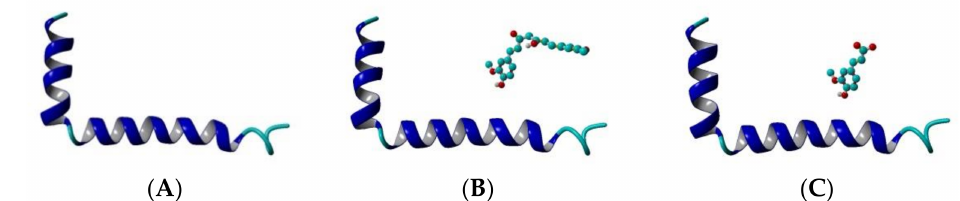
Figure 2. Initial topology of the systems modelled in the present study: ( A ) A β peptide, ( B ) A β peptide and CU, ( C ) A β peptide and FA. The peptide is given in cartoon, the ligand–in ball-and-stick. Structures are visualized by YASARA